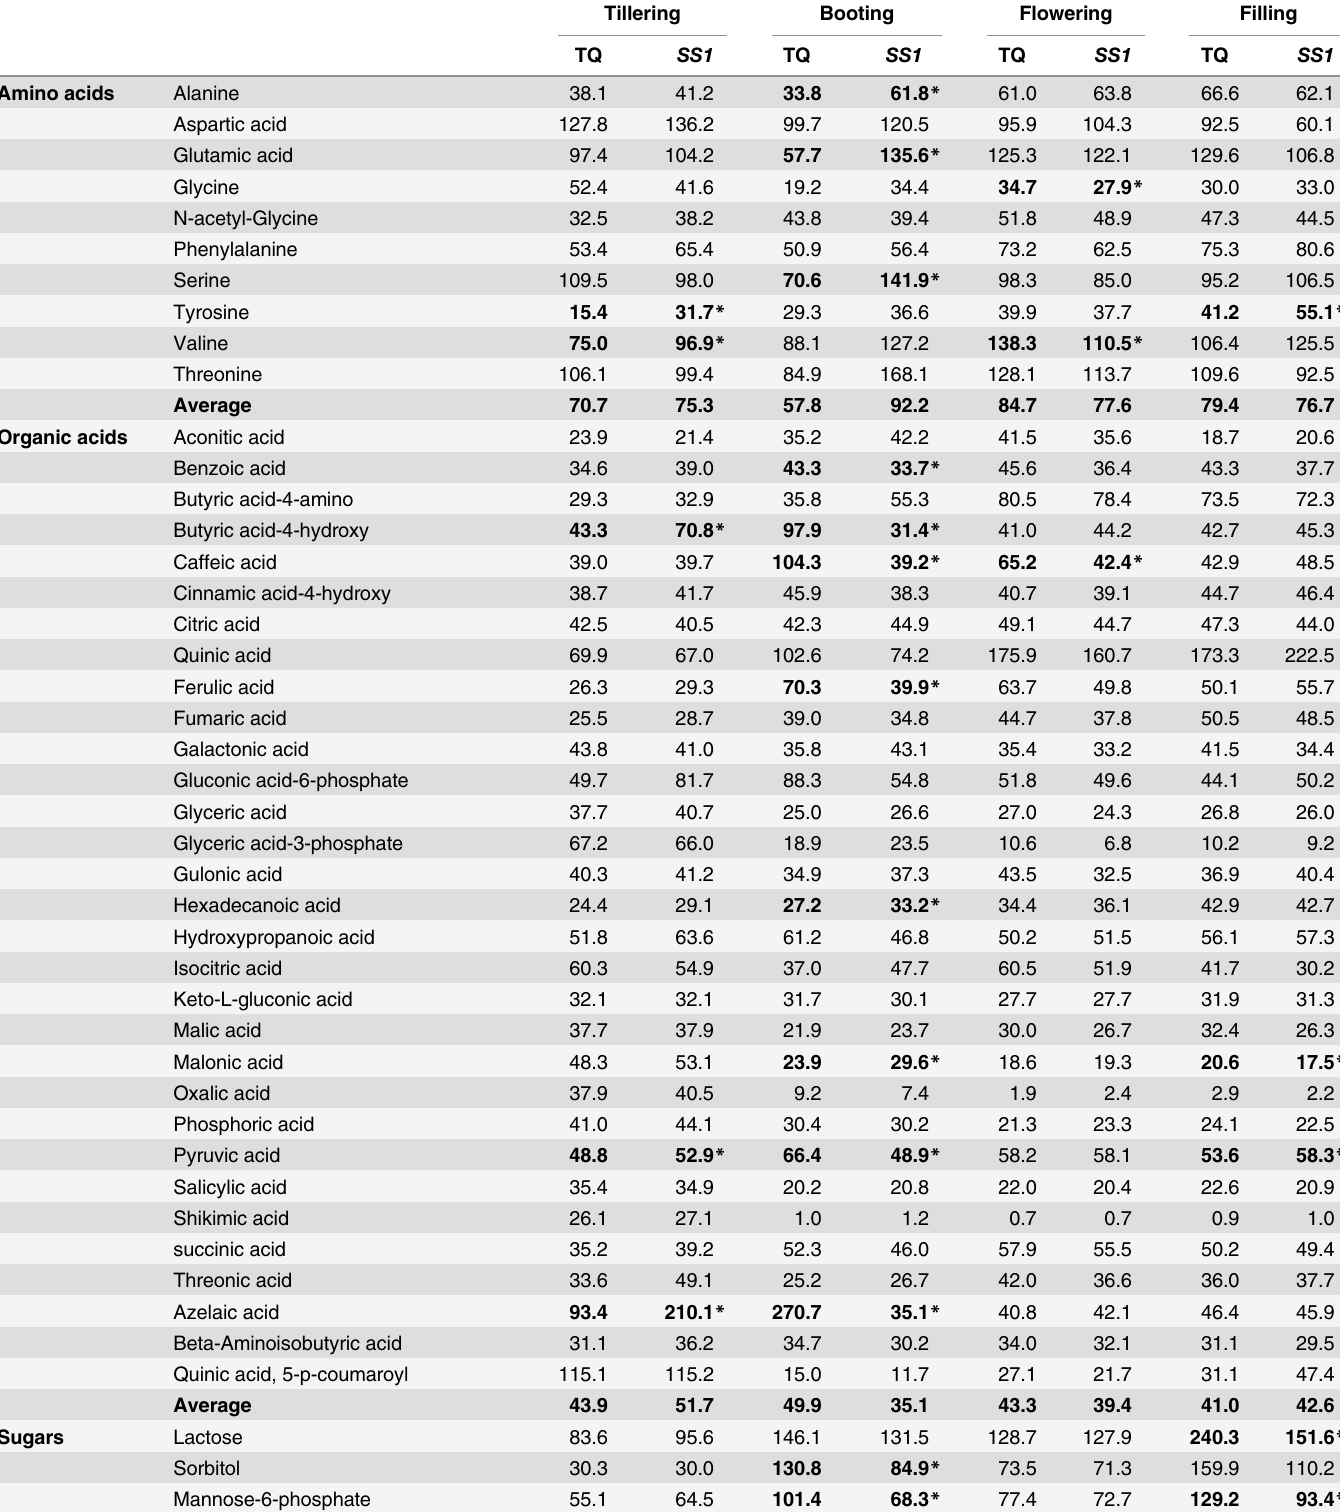
Table 2. Comparison of metabolite levels between leaves of NIL- SS1 ( SS1 ) and Teqing (TQ) at four different growth stages. Tillering Booting Flowering Filling